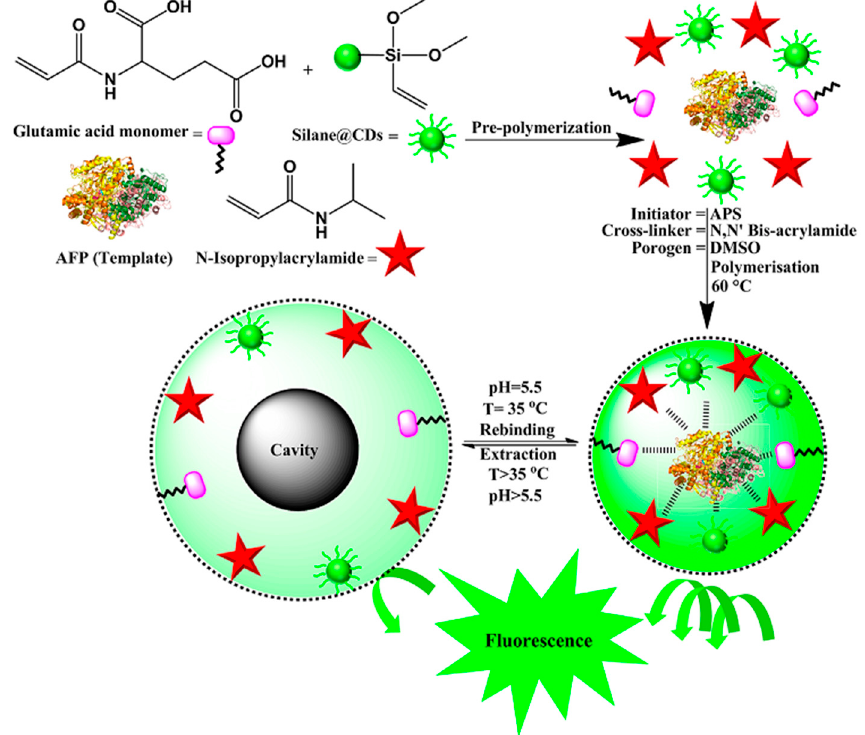
Figure 2. Schematic representation for the synthesis of fluorescence, stimuli-responsive AFP-imprinted polymer. Reprinted with permission from [21]. ©2015 Elsevier.